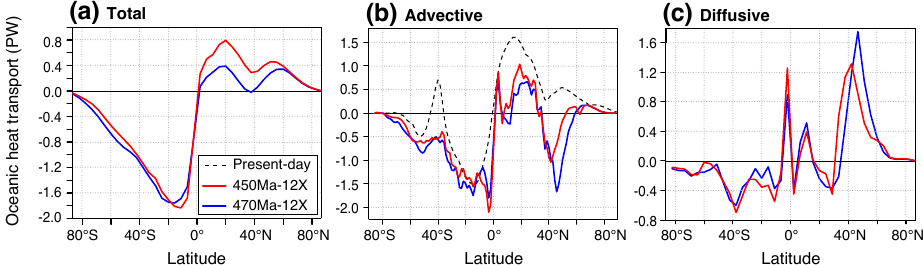
Figure 7. Comparison of the total, advective and diffusive OHT simulated with the fully coupled version of FOAM at 12PAL for the two continental configurations used in this study. The OHT is given in petawatts (1PW = 10 15 W). The present-day curve is the control experiment conducted at present-day conditions with the up-to-date IPSL (Institut Pierre Simon Laplace) CM4 GCM (see the main text for explanations).